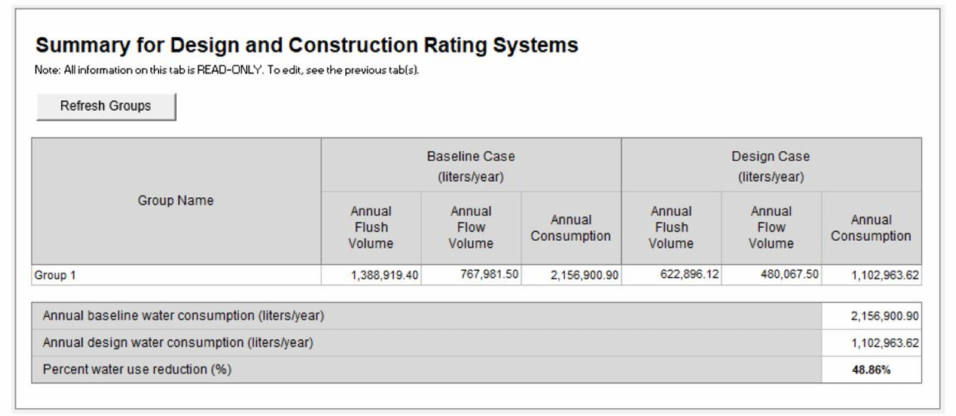
Figure 12. Annual simulation of water consumption. Comparative table. Source: Castaño & Asociados. Passivhaus engineering consultancy [66].